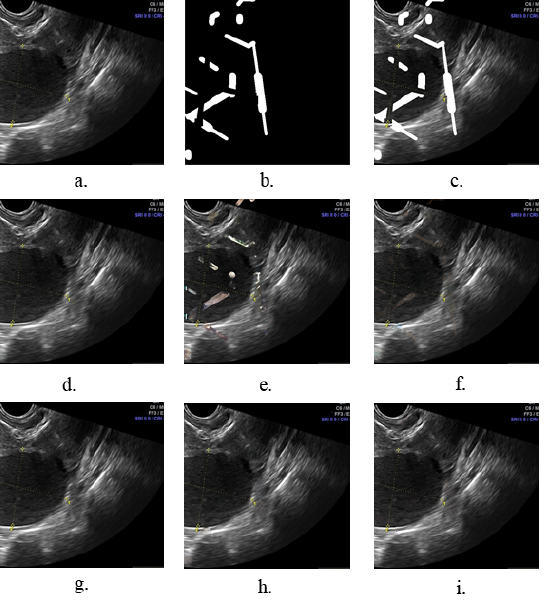
Figure A2. Comparison between the results of our proposed model and those of other models. ( a ) The ground truth image. ( b ) The mask for the ground truth image. ( c ) The masked image. ( d ) LaMa method. ( e ) GL method. ( f ) DF 1 method. ( g ) Our method. ( h ) PC method. ( i ) DF 2